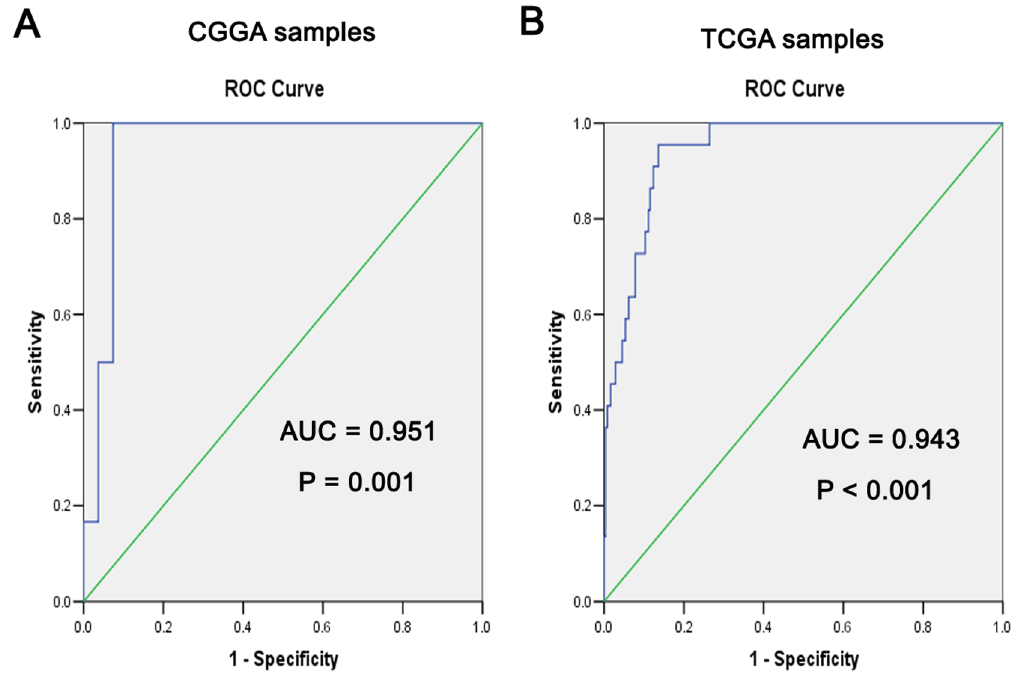
Figure 3. Hypermethylation of SOCS3 promoter is consistent with G-CIMP. A. In the CGGA samples, a ROC curve demonstrated a tight relationship between hypermethylation of the SOCS3 promoter and G-CIMP-positive status (AUC=0.951, P=0.001). B. In the TCGA samples, a similar relationship between hypermethylation of the SOCS3 promoter and G-CIMP-positive status is shown in the ROC curve (AUC=0.943, P , 0.001).